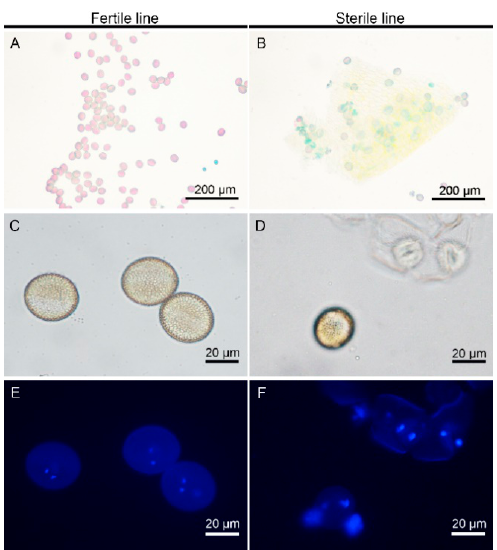
Figure 1. The morphology of flowers of “Bcajh97-01B” (fertile line) and “Bcpol97-05A” (sterile line) of Brassica campestris . Scale bars of 2 mm.